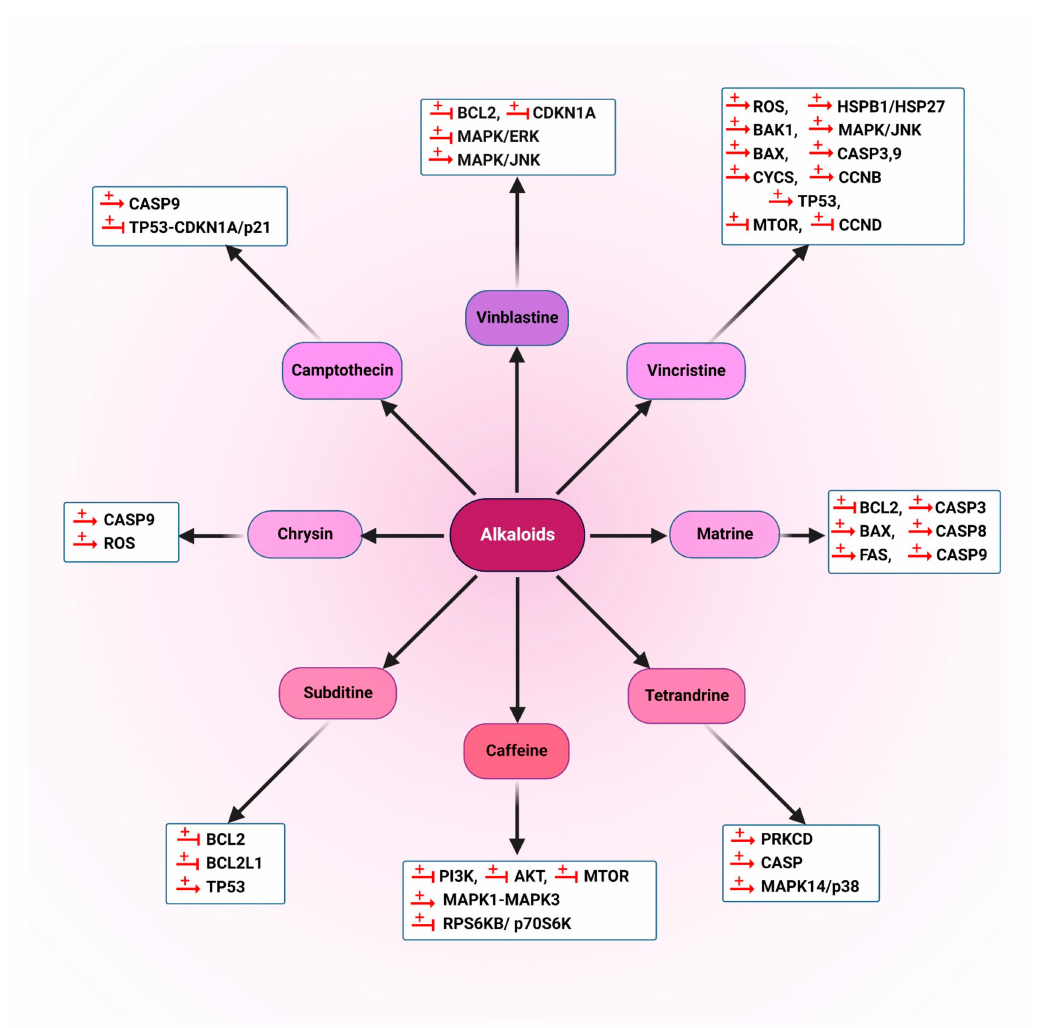
Figure 7. The schematic role of alkaloids on different proteins involved in the autophagy pathway. Alkaloids regulate autophagy in different ways. Vincristine and carbazoles have been demonstrated to inhibit autophagy by suppression of CD24, suppression of the PTEN-AKT-MTOR pathway and enhancement of SSQTM1/p62. Other alkaloids induce autophagy via activation of AMPK, TSC2, Figure 15. The schematic role of alkaloids on the proteins involved in the apoptosis pathway. MAPK/JNK-AP-1 and BECN1, and enhance MYC/c-Myc, LC3-II and ATG7 expression. Moreover, Alkaloids induce apoptosis in distinct cells via downregulation of CDKN1A/p21/WAF1/CIP1, BCL2, inhibiting the AKT-MTOR pathway has a key function in induced autophagy by alkaloids. Moreo- BCL2L1 and CCND while promoting the expression of some other proteins like CASP3, CASP8, ver, another alkaloid named tetrandrine induces autophagy by suppressing the WNT- CTNNB1/β - CASP9, CCNB, BAX, CYCS, BAK1 and FAS. Moreover, activation of MAPK/JNK, TP53, PRKCD and catenin pathway and decreasing MTA1 expression. → : Indicates activation or an increase in the mentioned protein expression. MAPK14/p38 signaling pathways, as well as inactivation of MAPK/ERK and RPS6KB/p70S6K, is observed in different cell lines treated with these alkaloids. → : Indicates activation or an increase in the mentioned protein expression. protein expression. +: means positive effect of the proteins on different pathways. The figure was : Indicates deactivation or a decrease in the mentioned protein expression. − and +: Indicate the effect created with BioRender.com. Licensing Right RD24OB7C3X, 21 November of the proteins on different pathways ( − means negative effect and + means positive effect). The figure was created with BioRender.com. Licensing Right VD24OB6Q8E, 21 November 2022.